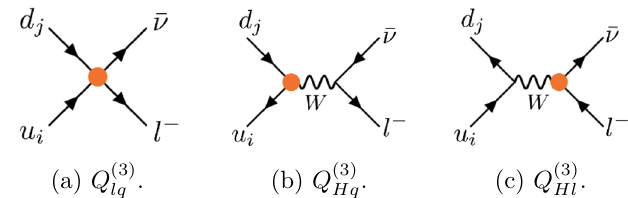
Figure 1. Tree level SMEFT diagrams generating meson decays which also proceed at tree level in the SM. The orange blobs represent insertions of the SMEFT operators Q (3)